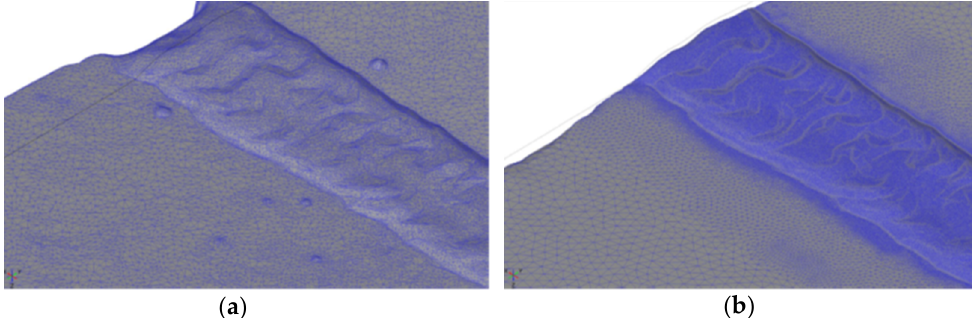
Figure 4. The appearance of the A3 sample surface shown in Salome software. ( a ) “uncleaned” surface; ( b ) surface after holes and weld droplets were cleaned